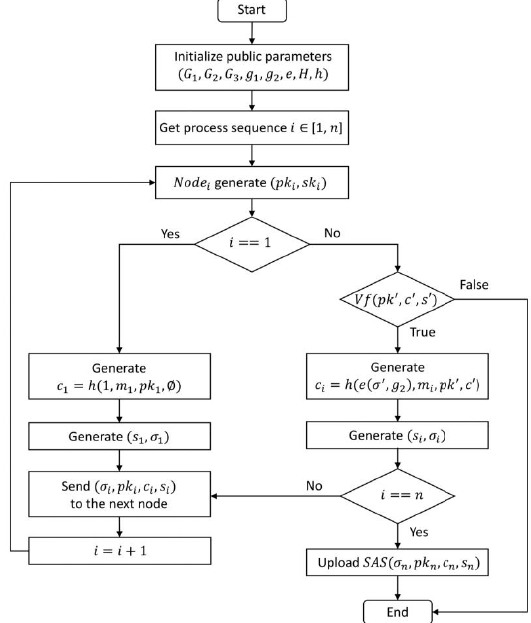
Figure 4. The flow chart of the execution of the process route.